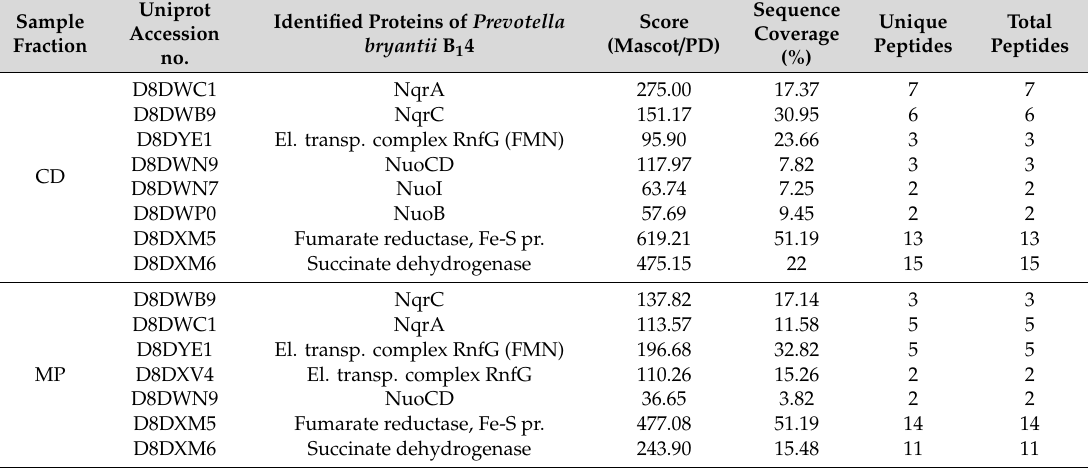
Table 2. Subunits of respiratory, NADH-converting complexes and other respiratory enzymes identified in the two proteome fractions (membrane proteins, MP and cell debris, CD) of P. bryantii B 1 4. The entirety of identified proteins is listed in Table S2.